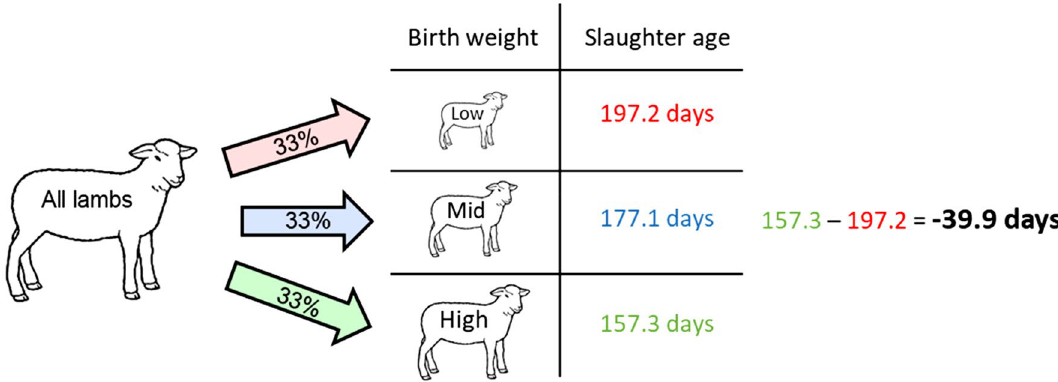
Figure 1. Proposed method to estimate the gross information value of a predictor. It is computed as the difference in end-of-season performance outcome (slaughter age in this example) between top (high) and bottom (low) groups, as defined mid-season according to the relevant predictor value (birth weight in this example). Top third and bottom third animals were allocated to ‘high’ and ‘low’ groups, respectively, for the baseline analysis. However, main results were insensitive to changes in how these two groups were defined. Produced by the authors using Microsoft